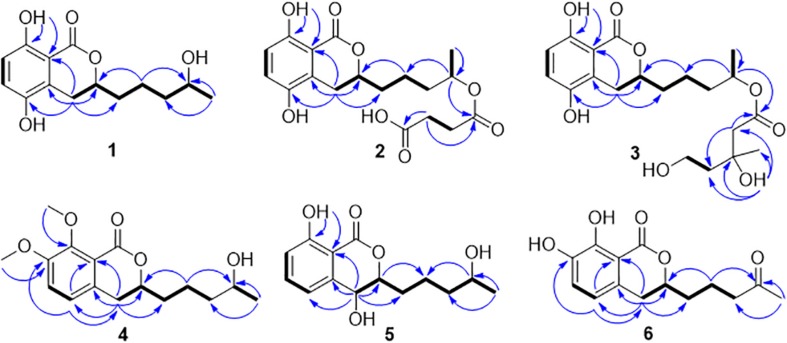
1H−1H COSY and key HMBC correlations observed for 1−6.